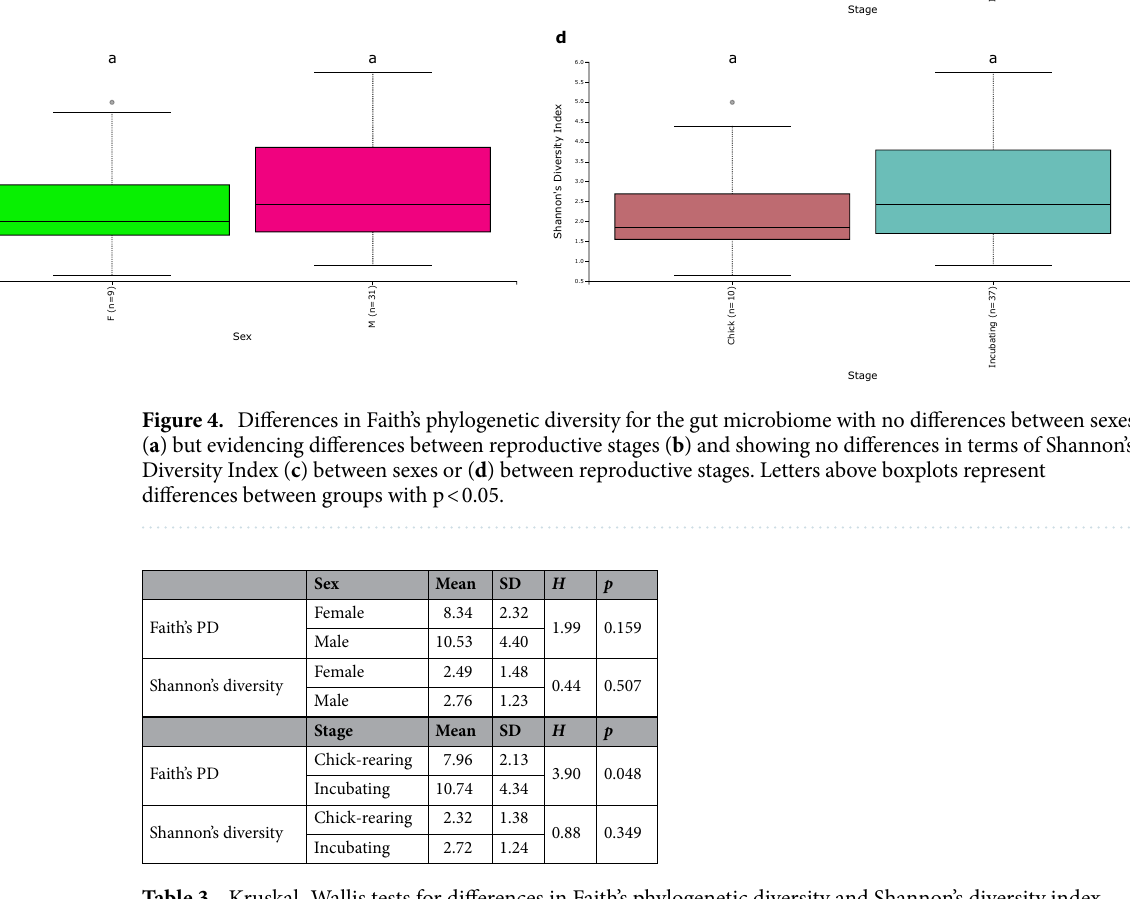
Table 3. Kruskal–Wallis tests for differences in Faith’s phylogenetic diversity and Shannon’s diversity index between sexes and reproductive